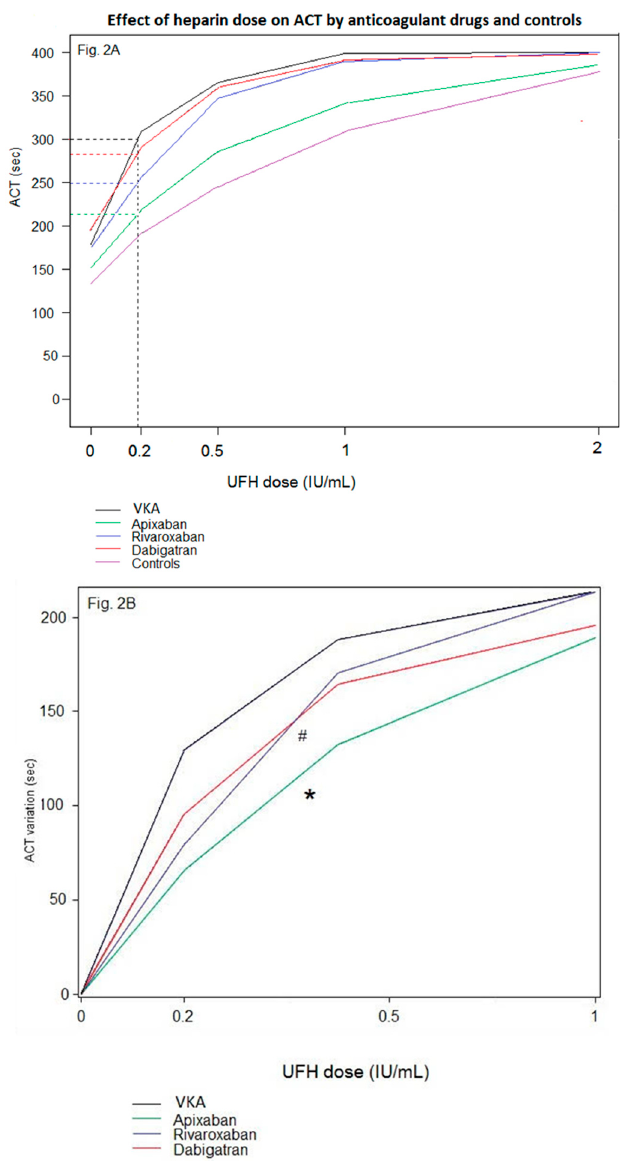
Figure 2. ( A ) E ff ects of increasing UFH doses on ACT values in patients receiving VKA, apixaban, rivaroxaban, dabigatran et controls. The mean UFH dose required to achieve the ACT target at 300 s in samples from VKA-treated patients (vertical dotted line) lead to an ACT close to 213 s in samples from apixaban treated-patients, an ACT close to 249 in samples from rivaroxaban treated-patients, and an ACT close to 284 in samples from dabigatran treated-patients. ( B ) ACT prolongation in response to increasing UFH doses in patients receiving VKA, apixaban, rivaroxaban, and dabigatran. The ACT dose-response curve to UFH observed in samples from VKA-treated patients was parallel to the curve observed with dabigatran, whereas it di ff ered significantly from the curves observed with rivaroxaban or apixaban between 0 and 0.2 UFH dose (IU / mL) (* p < 0.001 for VKA vs apixaban, # p = 0.003 for VKA vs.